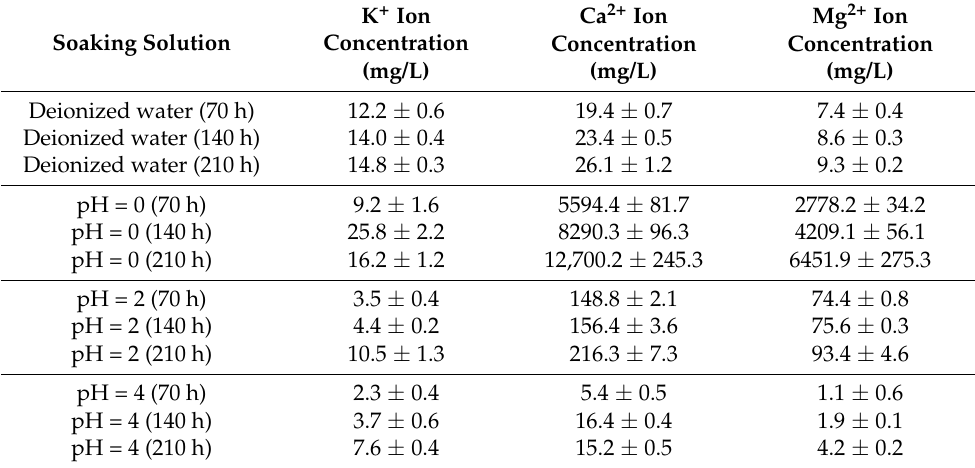
Table 3. Concentrations of K + , Na + , Ca 2+ , and Mg 2+ in different solutions.